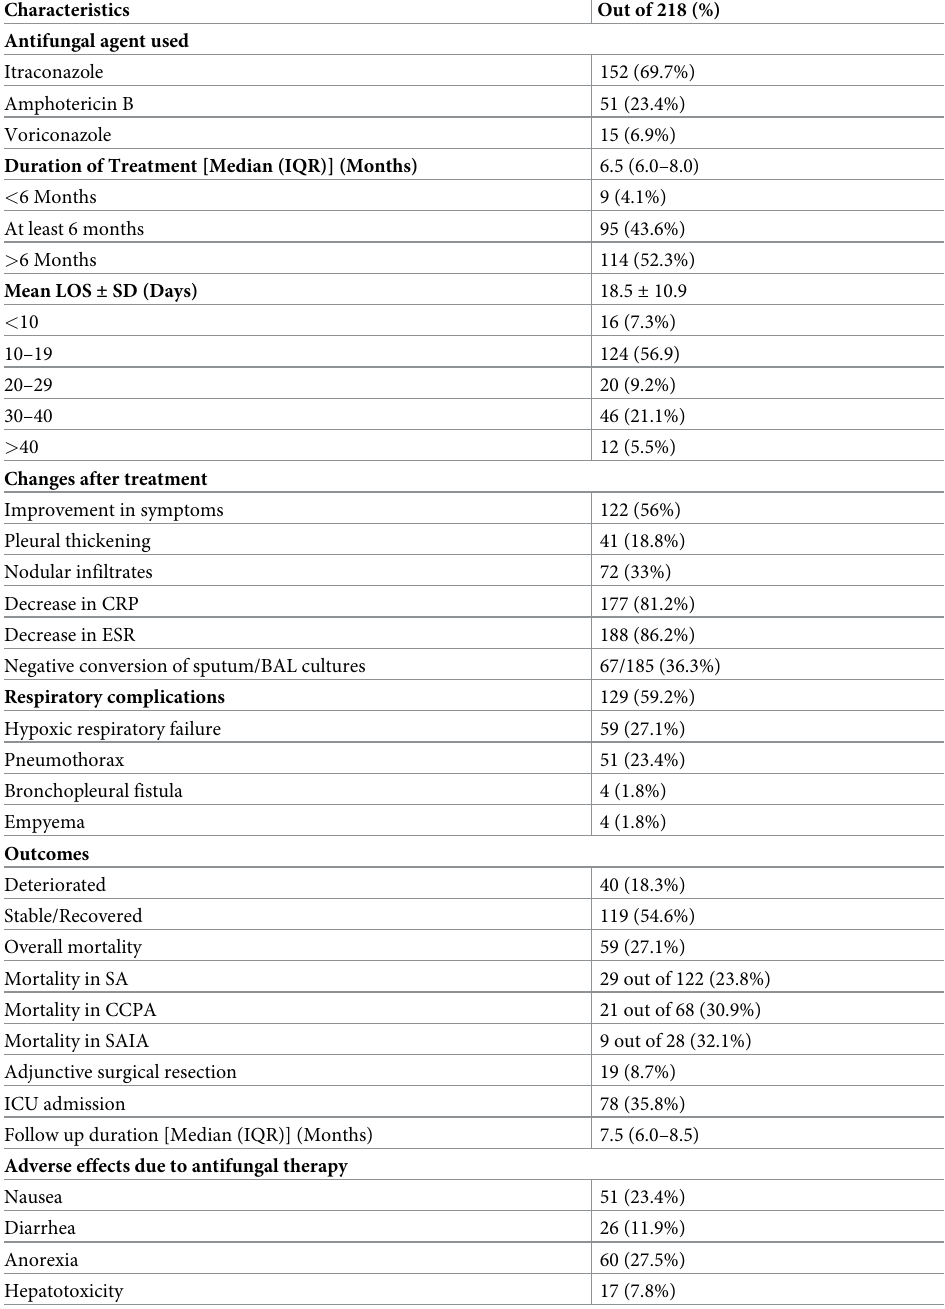
Table 3. Responses to therapy and